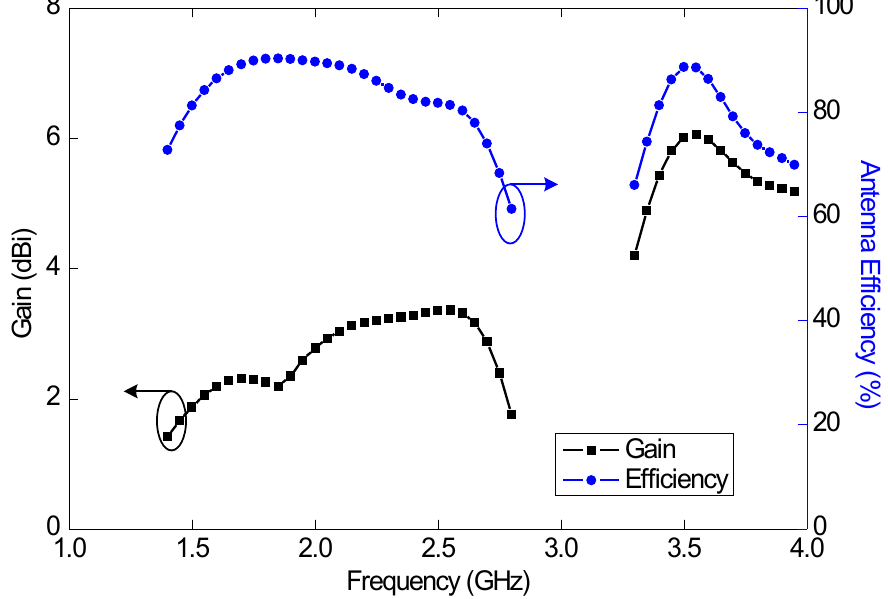
Figure 10. Predicted antenna efficiency and realized gain of the dual-band antenna (Ant#2). The normalized E θ and E φ radiation patterns in the three principal planes at 1.8, 2.6, to the maximum of the corresponding principal plane. The E φ pattern in the x–z plane at